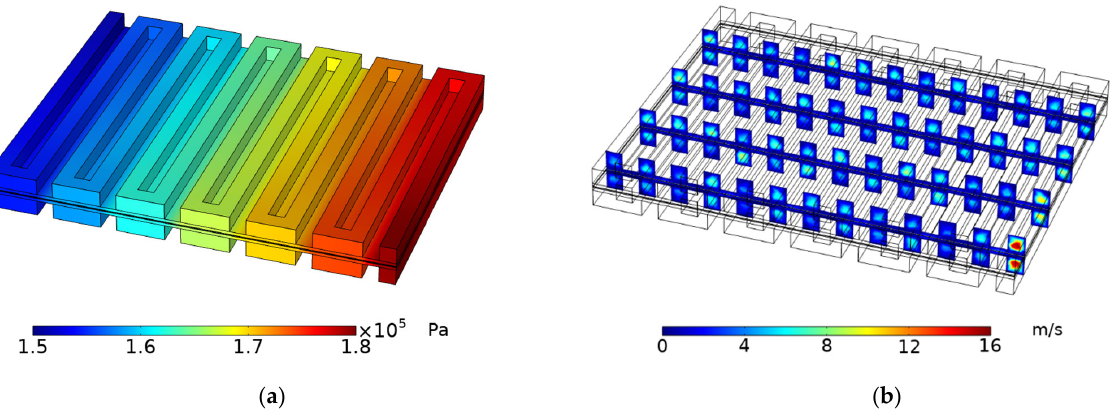
Figure 5. ( a ) Pressure distribution throughout the cell; ( b ) velocity distribution in four different sections of the cell.